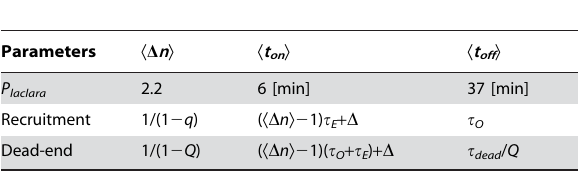
Table 1. Relations between model parameters and the average Æ D n æ , Æ t on æ , and Æ t off æ